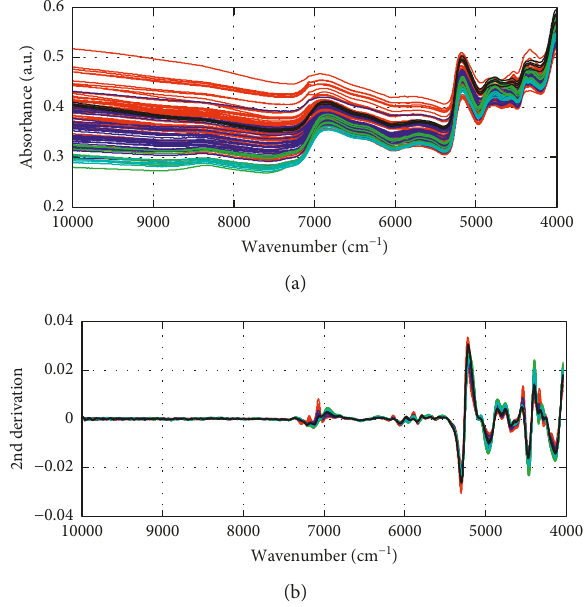
Figure 1: Raw near-infrared spectra (a) and the 2nd derivation preprocessed near-infrared spectra (b) of the Salvia miltiorrhiza